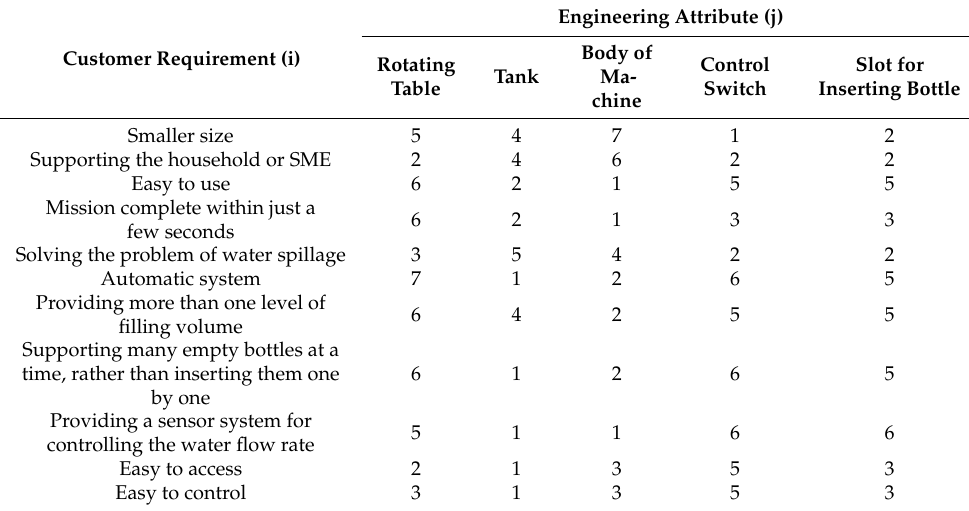
Table 5. The relationship between customer requirements and engineering attributes.